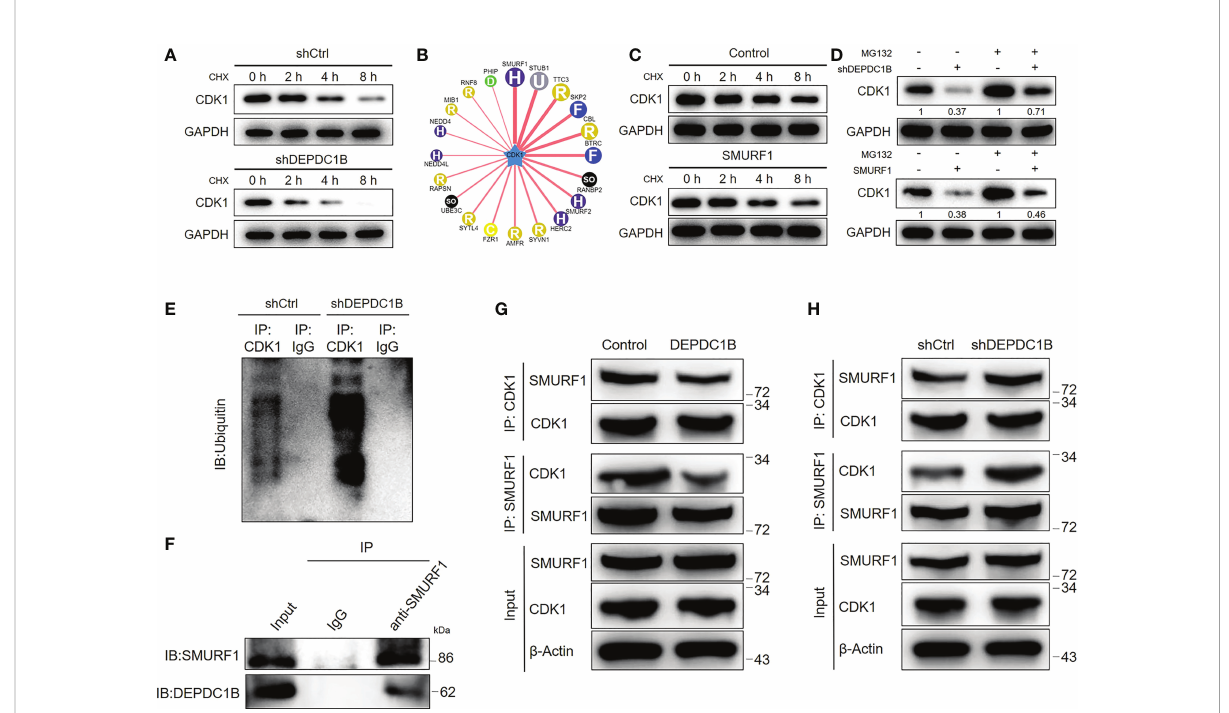
FIGURE 5 DEPDC1B regulates CDK1 expression through the ubiquitin – proteasome system. (A) The protein level of CDK1 was detected in shCtrl and shDEPDC1B HUCCT1 cells upon the treatment of cyclohexane (CHX) for indicated times. (B) The UbiBrowser online tool was used for predicting the E3 ligase of CDK1. (C) The protein level of CDK1 was detected in HUCCT1 cells with or without SMURF1 overexpression upon the treatment of cyclohexane (CHX) for indicated times. (D) The regulatory effects of the CDK1 protein level by DEPDC1B knockdown or SMURF1 overexpression were evaluated with or without treatment of proteasome inhibitor MG132. (E) An immunoprecipitation assay was performed for assessing the ubiquitination modi fi cation of CDK1 in shCtrl and shDEPDC1B HUCCT1 cells. (F) The interaction between DEPDC1B and SMURF1 was detected and veri fi ed by a co-immunoprecipitation assay using the IgG or SMURF1 antibody for obtaining a protein complex. (G, H) Total lysates of CCA cells with or without DEPDC1B overexpression (G) or DEPDC1B knockdown (H) were subjected to immunoprecipitation using anti-CDK1 or anti-SMURF1, followed by Western blotting analysis using indicated antibodies. All groups of cells were treated with MG132 to inhibit the function of